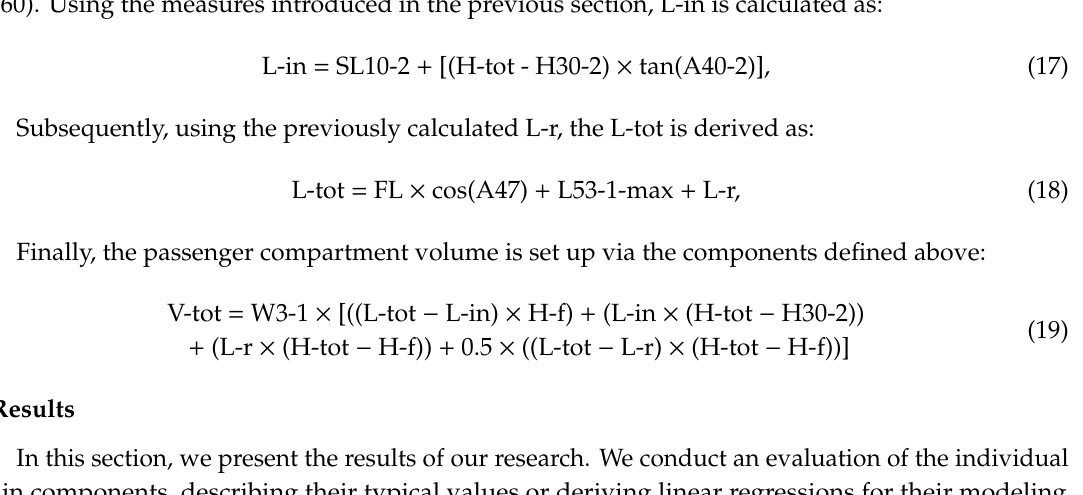
Table 1. Overview of the empirical values for the dimensional chain in the X-direction.